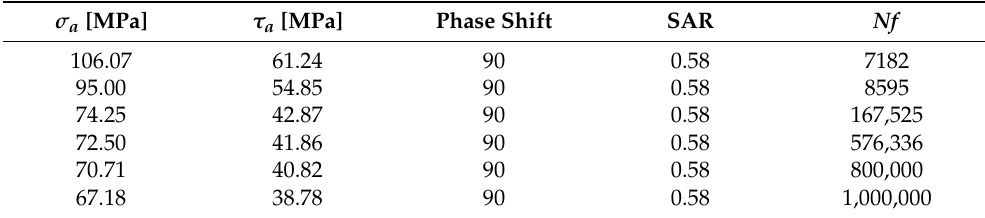
Table 2. Fatigue life results for AZ31BF at non-proportional reference load ( OP ). σ a